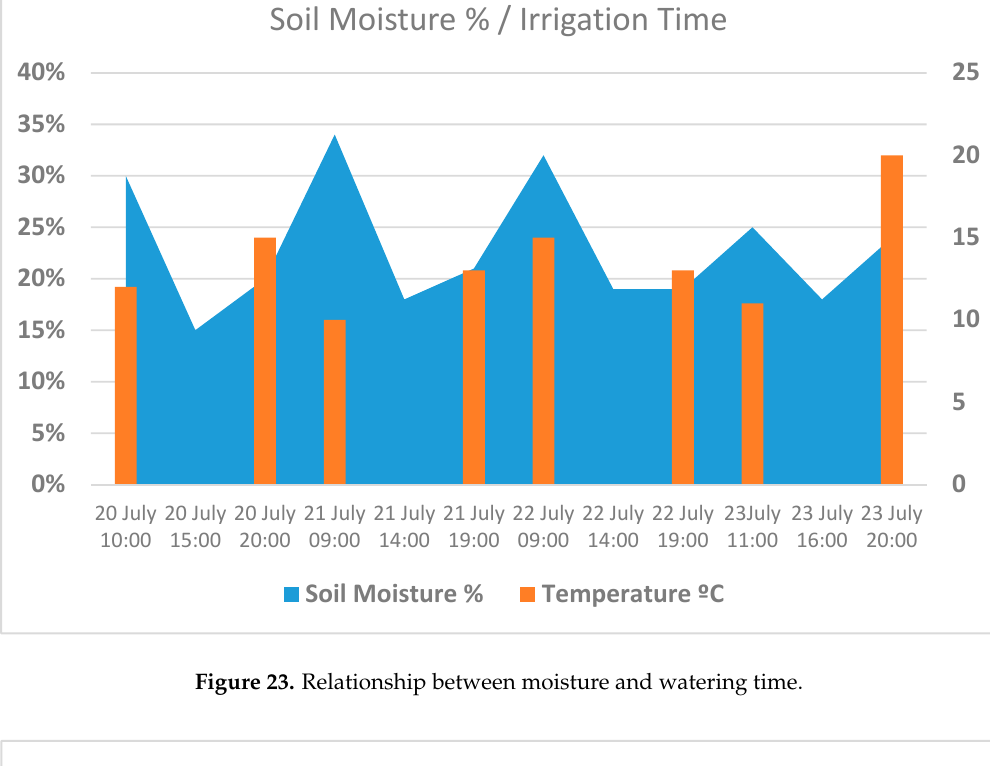
Figure 22. Relationship between the watering time and temperature.